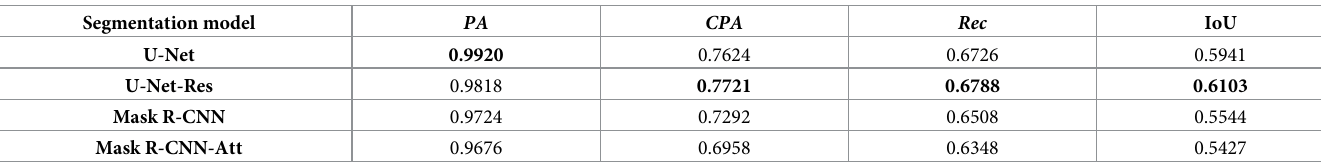
Table 2. Experimental results on evaluation metrics for 2 280 samples of thorax bone SPECT